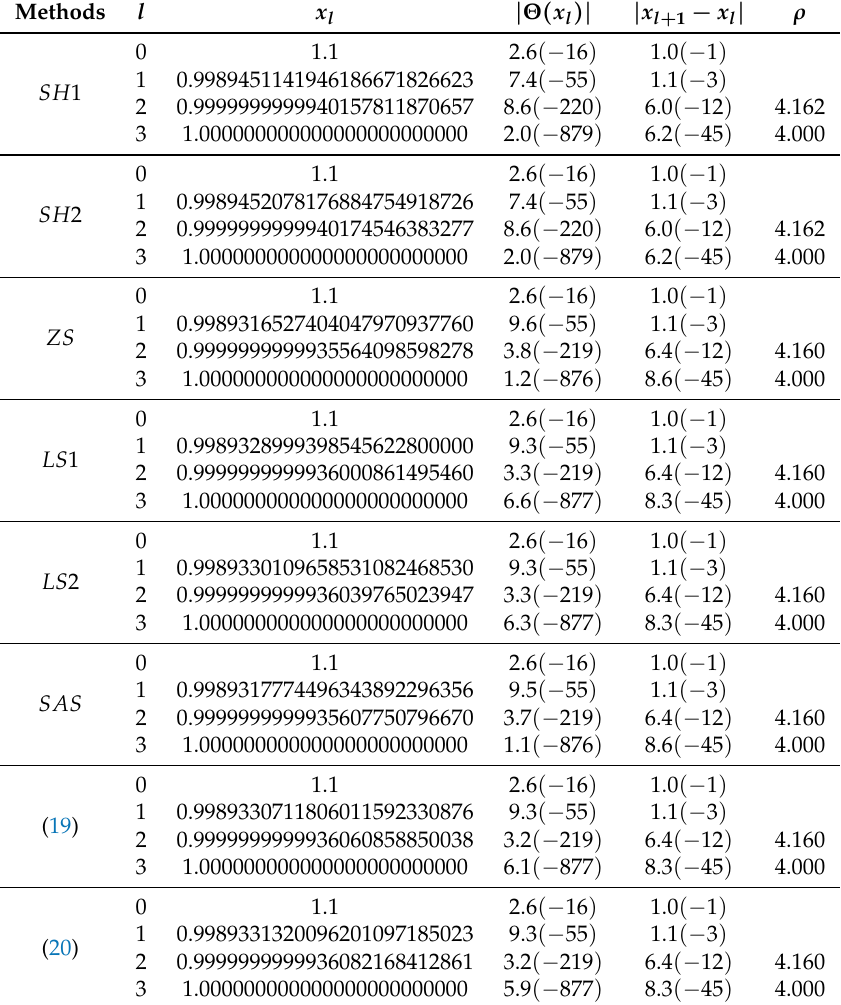
Table 6. Convergence study of distinct iterative functions on Θ 6 ( x )